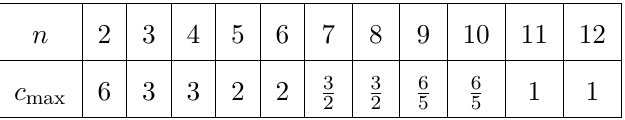
Table 1 . Upper bound c max on the central charge of the seed theory for which a twist n marginal operator can